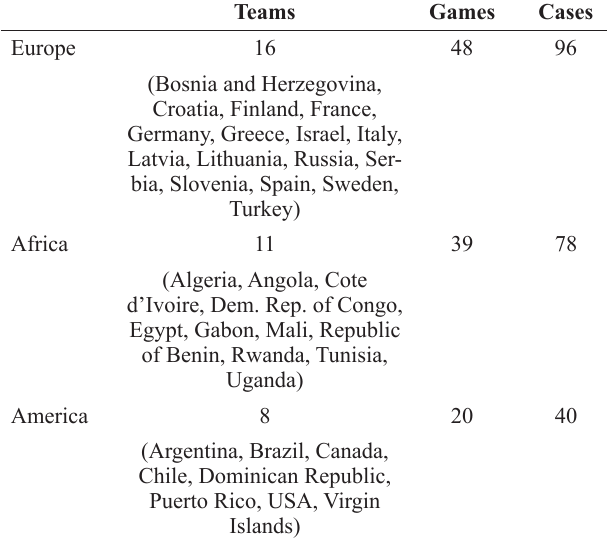
Table 1. Sample characteristics. Teams Games